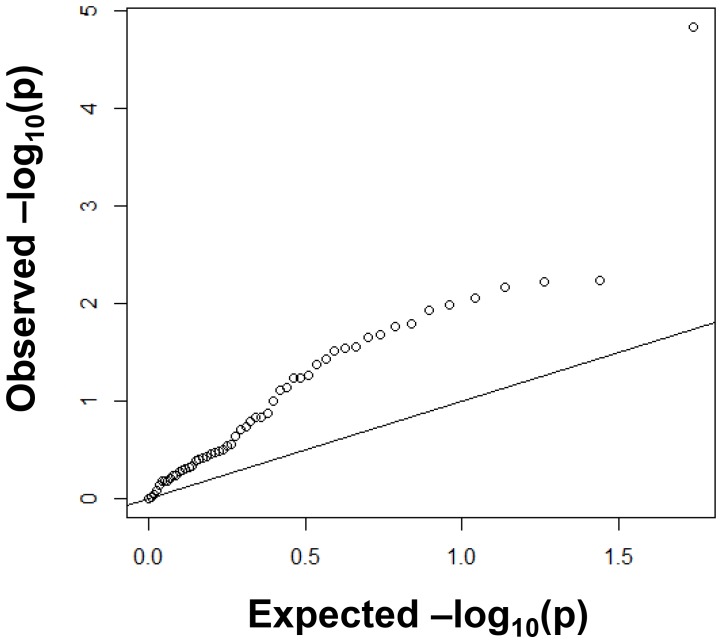
QQ-plot of 55 T2D SNPs reported by GWAS-catalog.Observed distribution of −log P-values were compared to the expected (null) distribution.